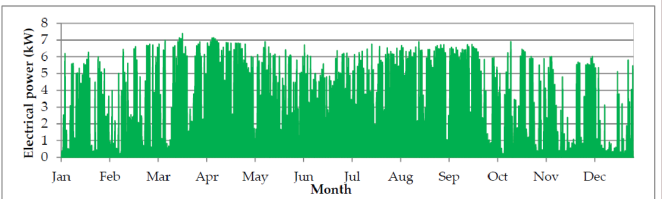
Figure 12. The simulated hourly electrical power output of the 9.6 kWp photovoltaic